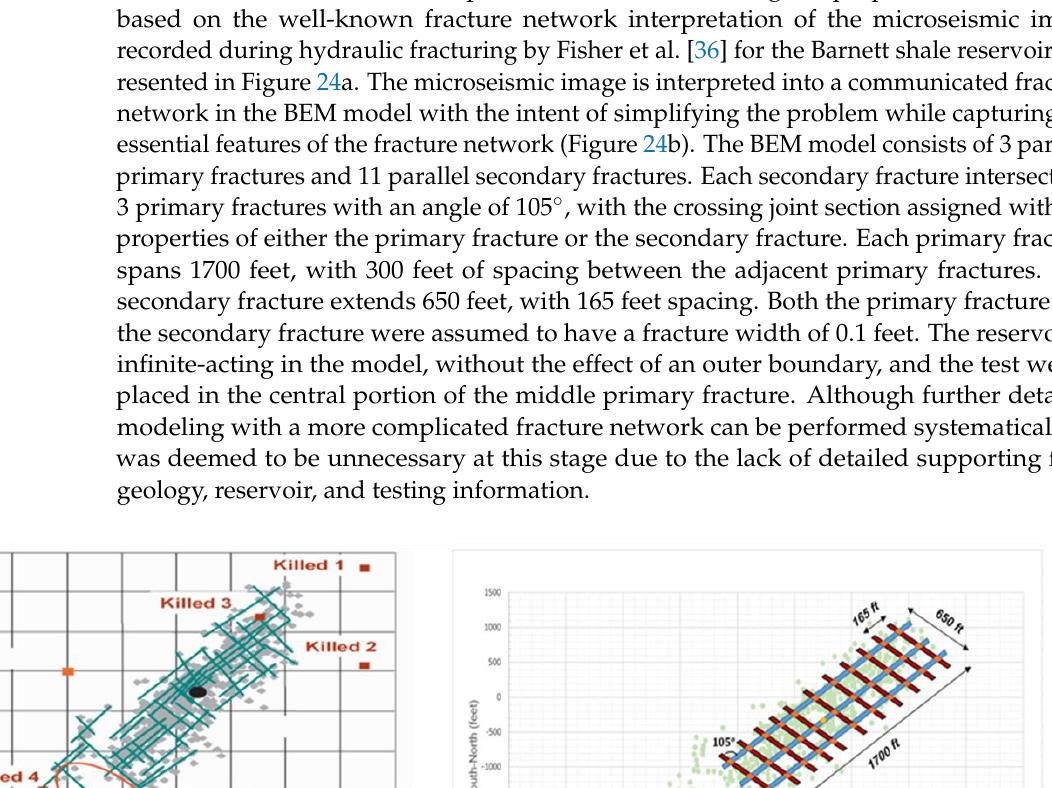
Table 1. The fracture mobility parameters for the cases based on the simplified fracture network model after Fisher et al. [36].